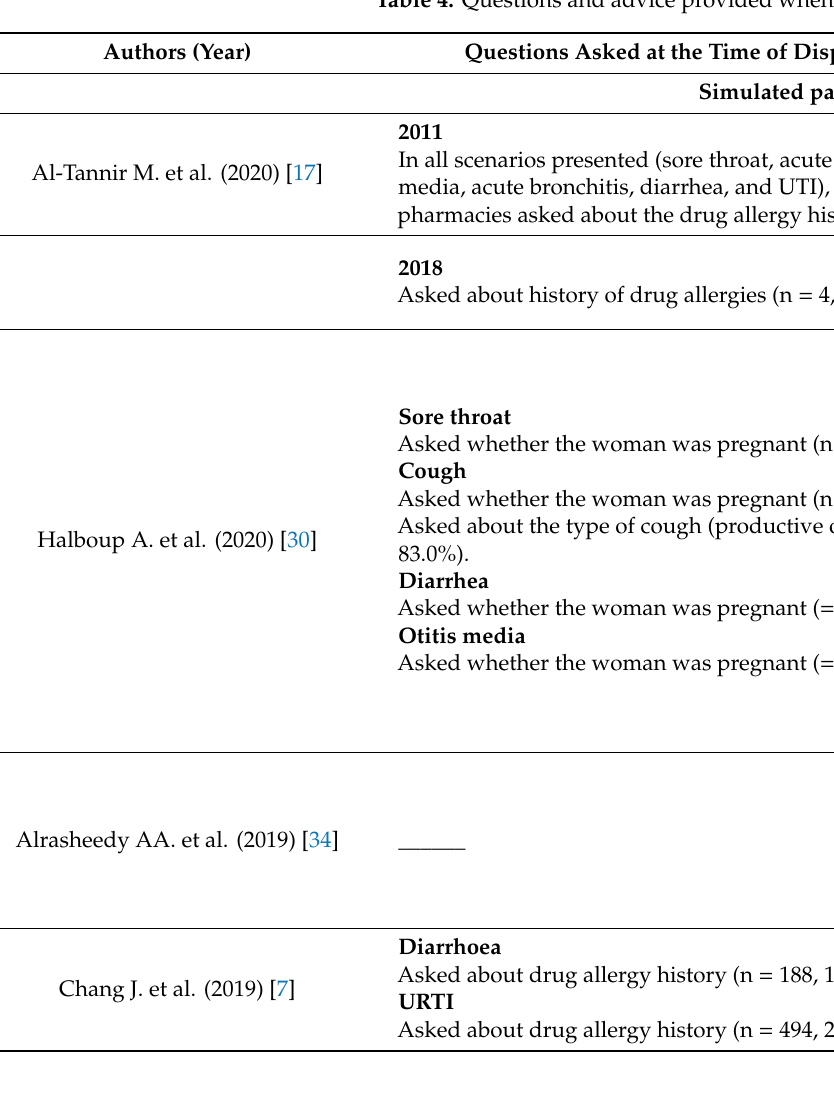
Table 4. Questions and advice provided when dispensing antibiotics without a